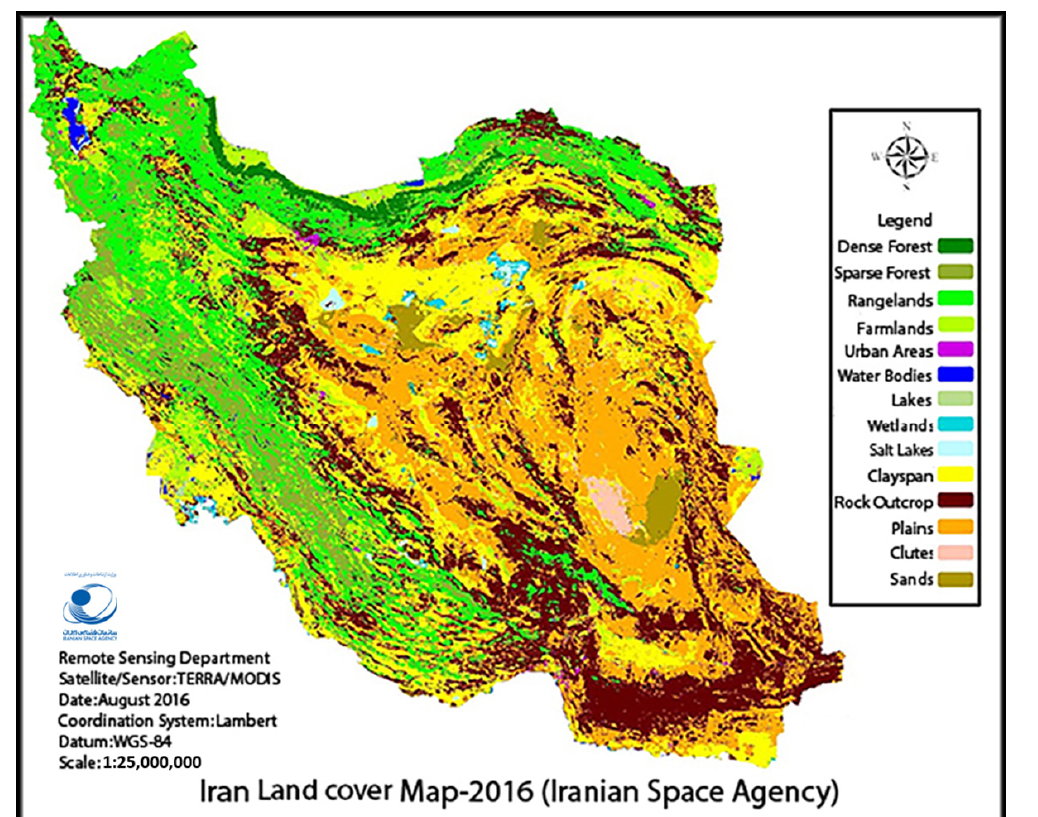
Figure 8. Iran land cover pap produced by the Iranian Space Agency (2016).